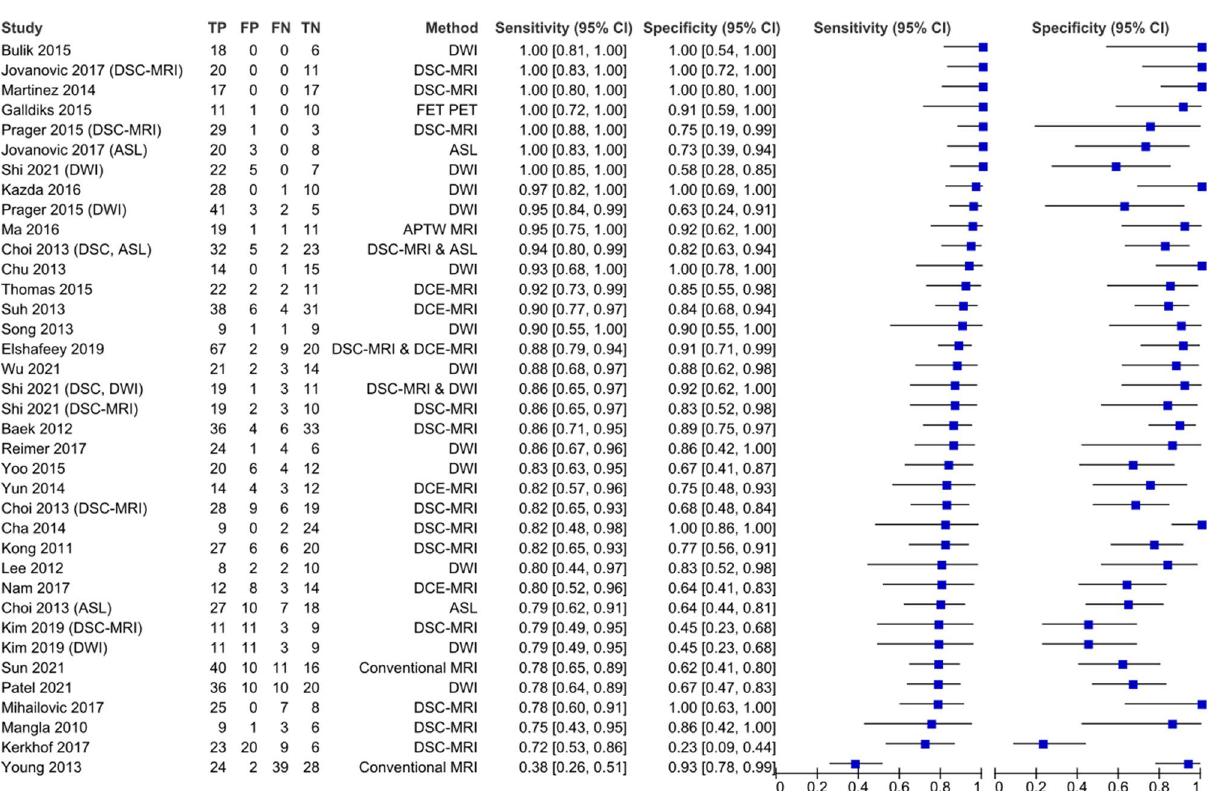
Figure 2. Forest plot assessing various methods of differentiation of pseudoprogression from true progression according to measures of sensitivity and specificity. APTw-MRI = amide proton transfer-weighted MRI; ASL = arterial spin labelling; DCE-pMRI = dynamic contrast-enhanced perfusion MRI; DSC-pMRI = dynamic susceptibility contrast perfusion MRI; DWI = diffusion weighted imaging; FET PET = [18F]fluoroethyltyrosine